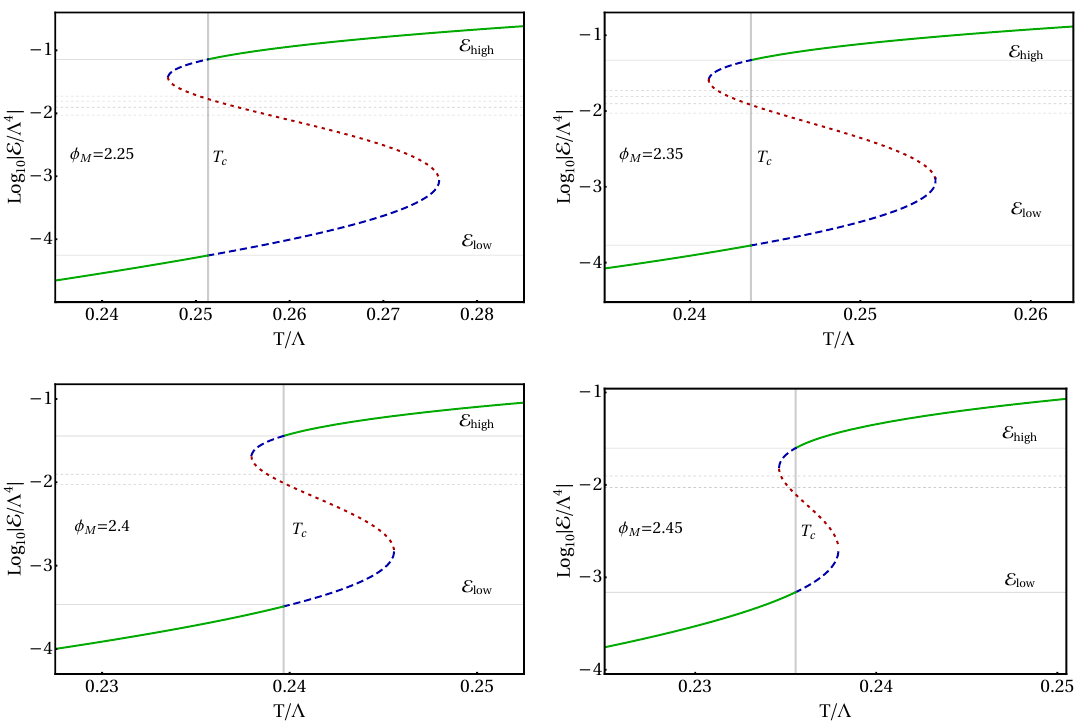
Figure 1 . Energy density versus temperature for the theories with different first order phase transitions with varying criticality due to different parameter φ M = { 2 . 25 , 2 . 35 , 2 . 4 , 2 . 45 } . The full green line represents the energy densities in the cold and hot stable phases, the dashed blue in the meta stable regions and the dotted red in the unstable region. The vertical full gray line marks the temperature of the phase transition T c . The horizontal full grey lines mark the stable energy densities E low and E high at the transition temperature. The horizontal dashed grey lines are the four initial energy densities {E 1 , E 2 , E 3 , E 4 } or just the two initial respective {E 1 , E 2 } of the simulations.